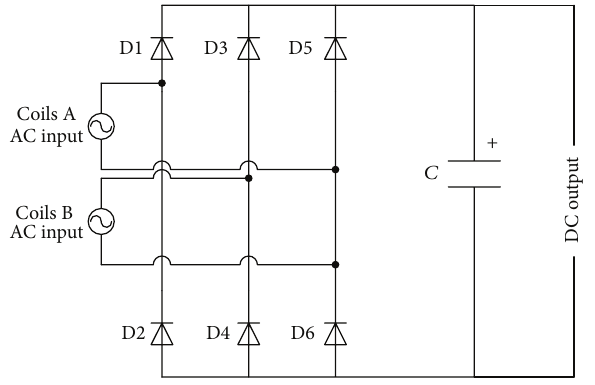
Figure 15: Schematic of the AC-DC rectifier.